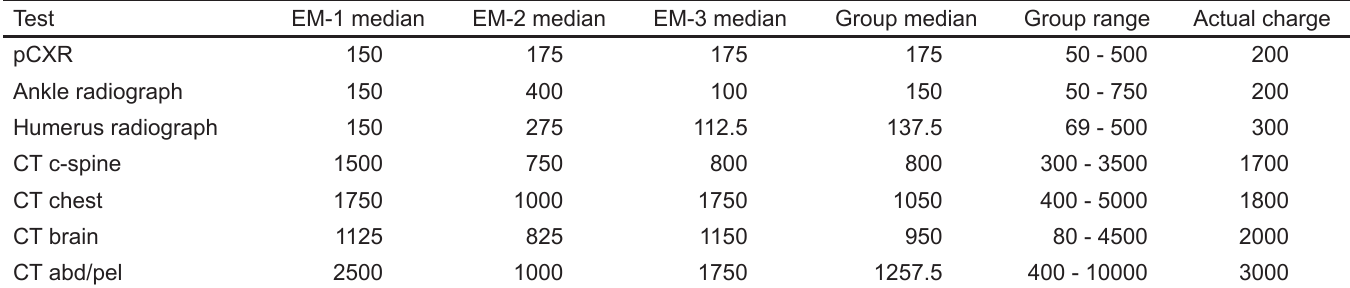
Table 2. Residents’ estimates of radiology testing charges (U.S. dollars) compared to the actual cost to